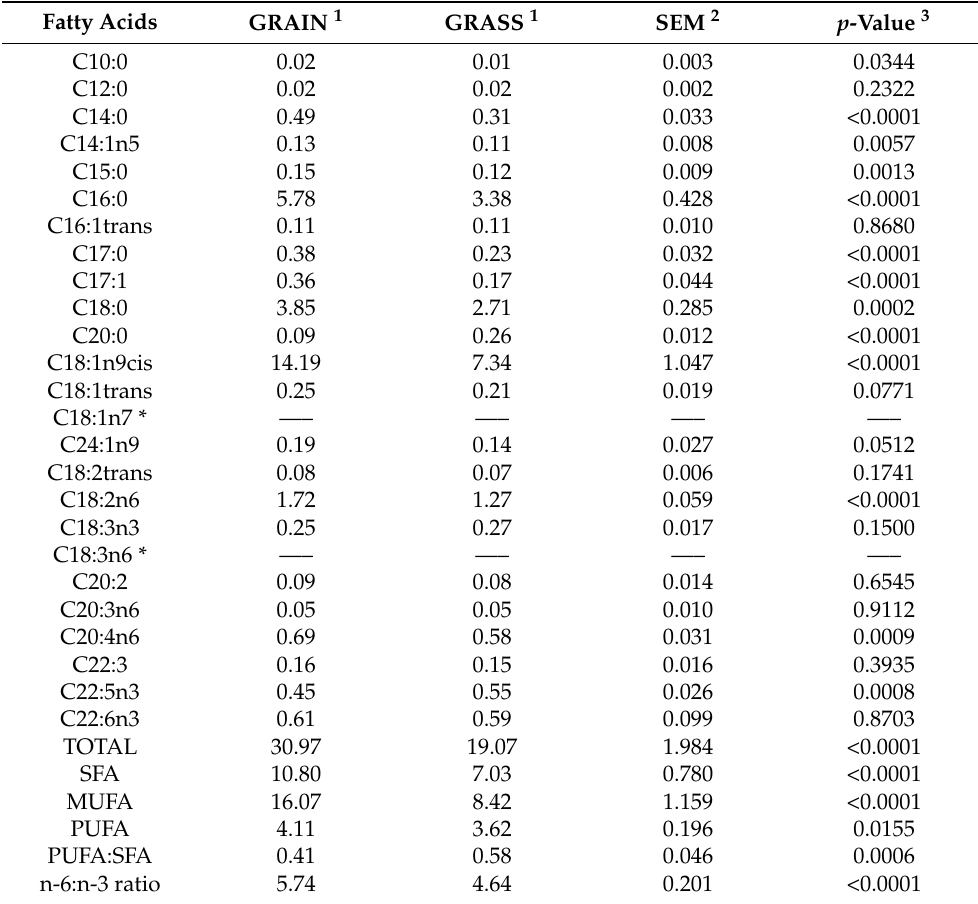
Table 4. Least square means for the effect of finishing system on the fatty acid composition (mg/g wet sample basis) of raw tissue from bison longissimus dorsi of grain- or grass-finished bison heifers. Fatty Acids GRAIN 1 GRASS 1 SEM 2 p -Value